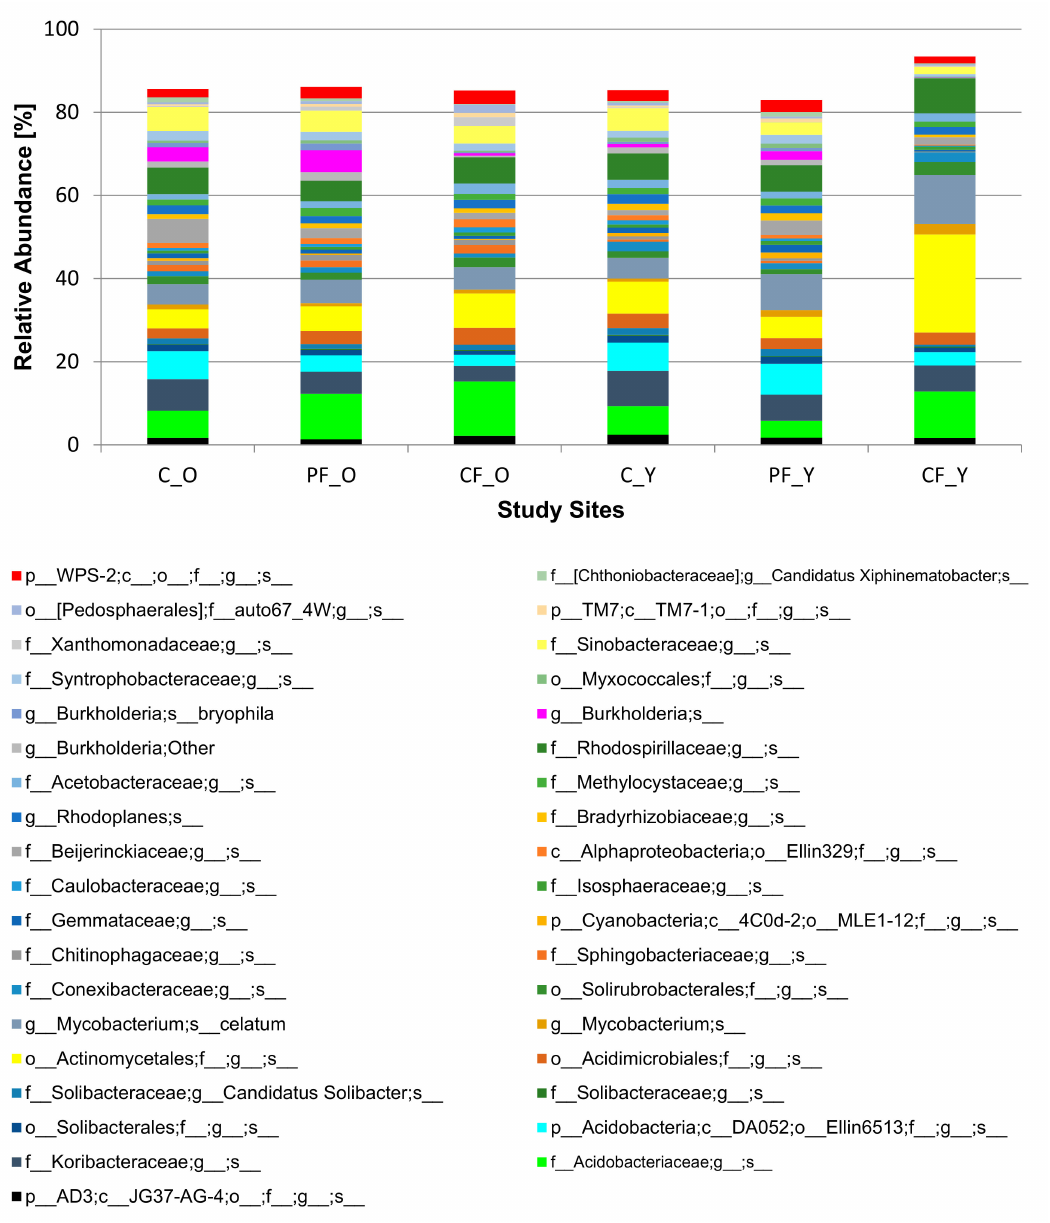
Figure 4. The relative distribution of dominant prokaryote species in soil collected from the C—control; PF—peripheral fire; CF—central fire areas; Y—young pine stand; O—old pine stand. Note: little letter estimate: p—phylum, c—class, o—order, f—family, g—genus, s—species. The data represent the